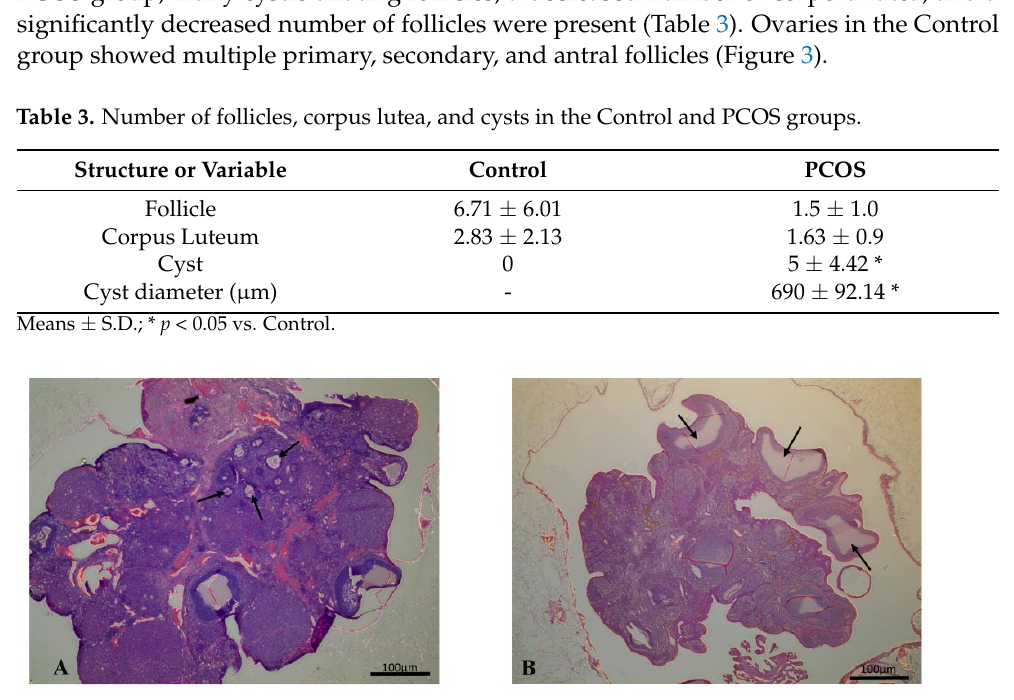
Table 4. Changes in the hematological parameters in Control and polycystic ovary syndrome (PCOS) group. Variable Group